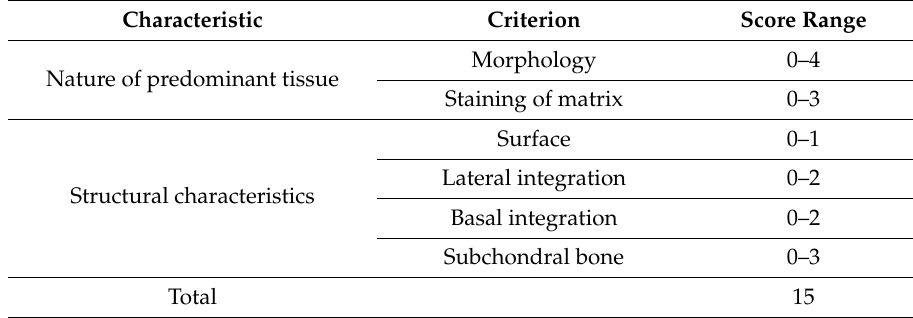
Table 3. Criteria of the used modified O´Driscoll score with a score range from 0 (worst) to 15